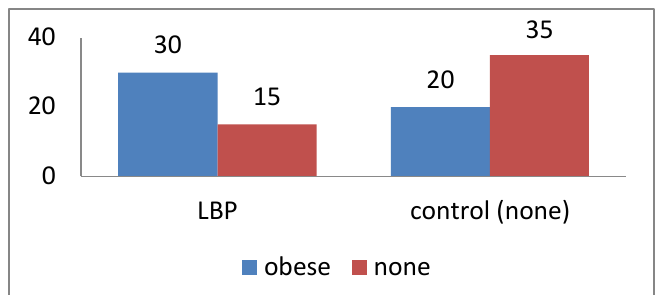
Figure 1: number of obese participants in both groups.